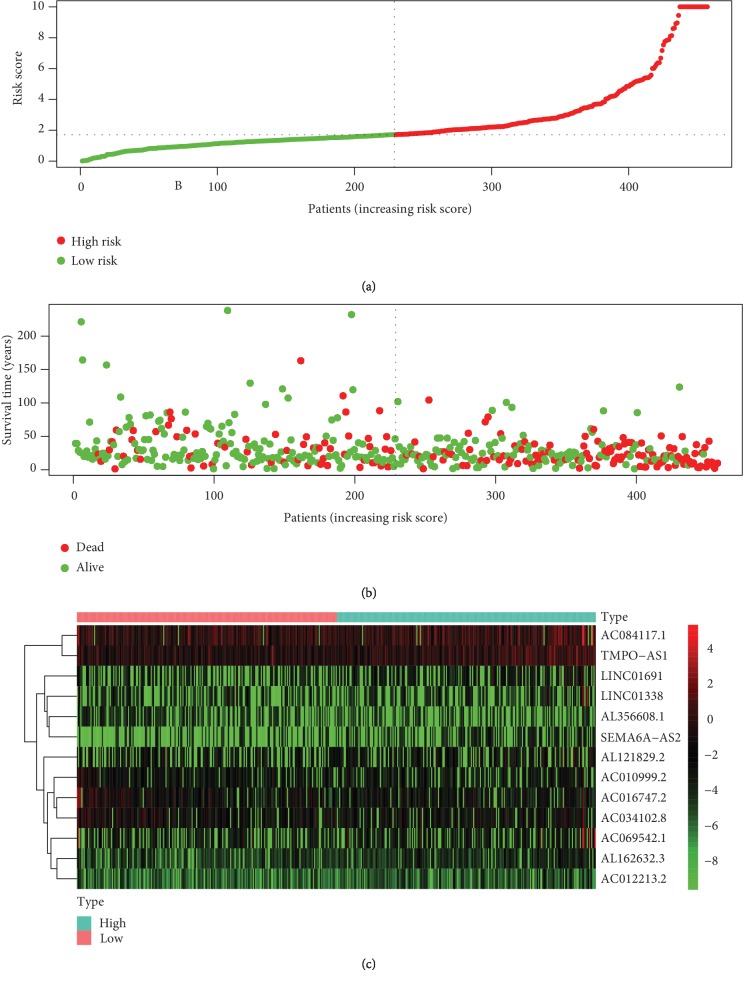
(a) The distribution of the risk scores of the 457 total included cases. (b) The distribution of OS time and status of the 457 total included cases. (c) Heatmap of the expression of the 13 lncRNAs in the low risk score and high risk score groups, with red indicating high expression and green indicating low expression.